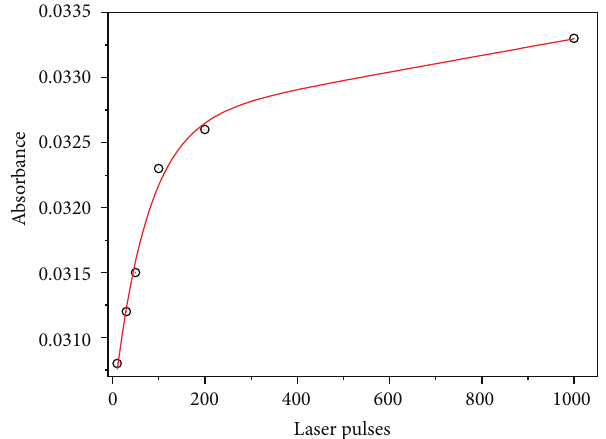
Figure3:Variousabsorbancesofthesamplearound610 nm(2.0eV) irradiated by different pulse numbers in vacuum; the pulse energy is 8.16 J/cm 2 .